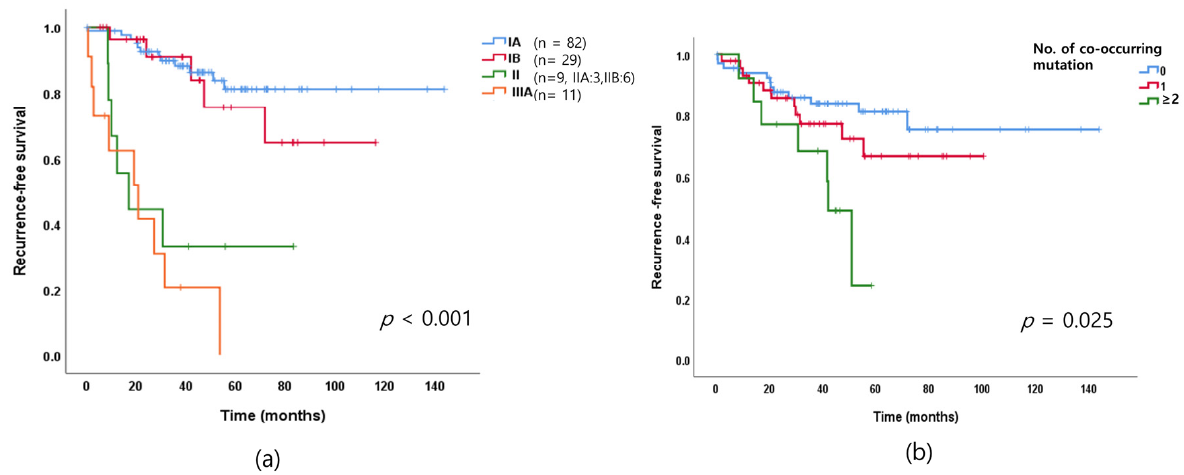
Figure 2. ( a ) Recurrence-free survival (RFS) in EGFR -mutated lung cancer according to ( a ) cancer stage and ( b ) number of co-occurring mutations. The RFS was significantly shorter according to the number of mutations co-occurring with the EGFR